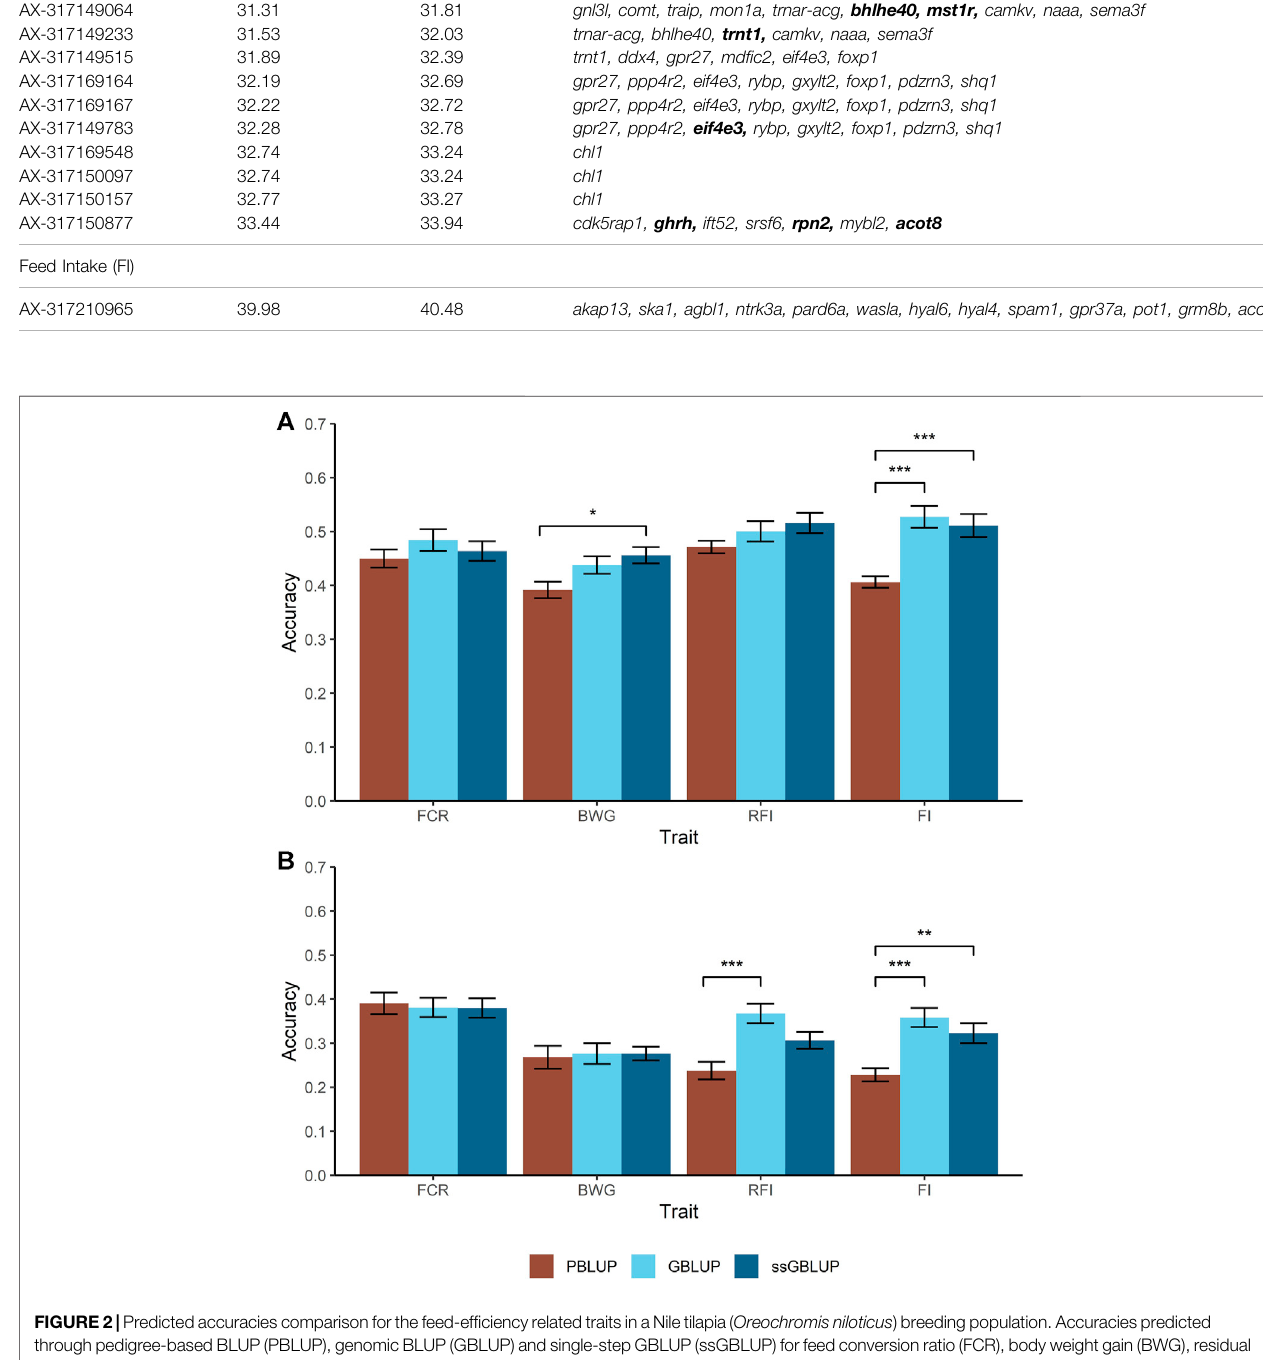
Frontiers in Genetics |